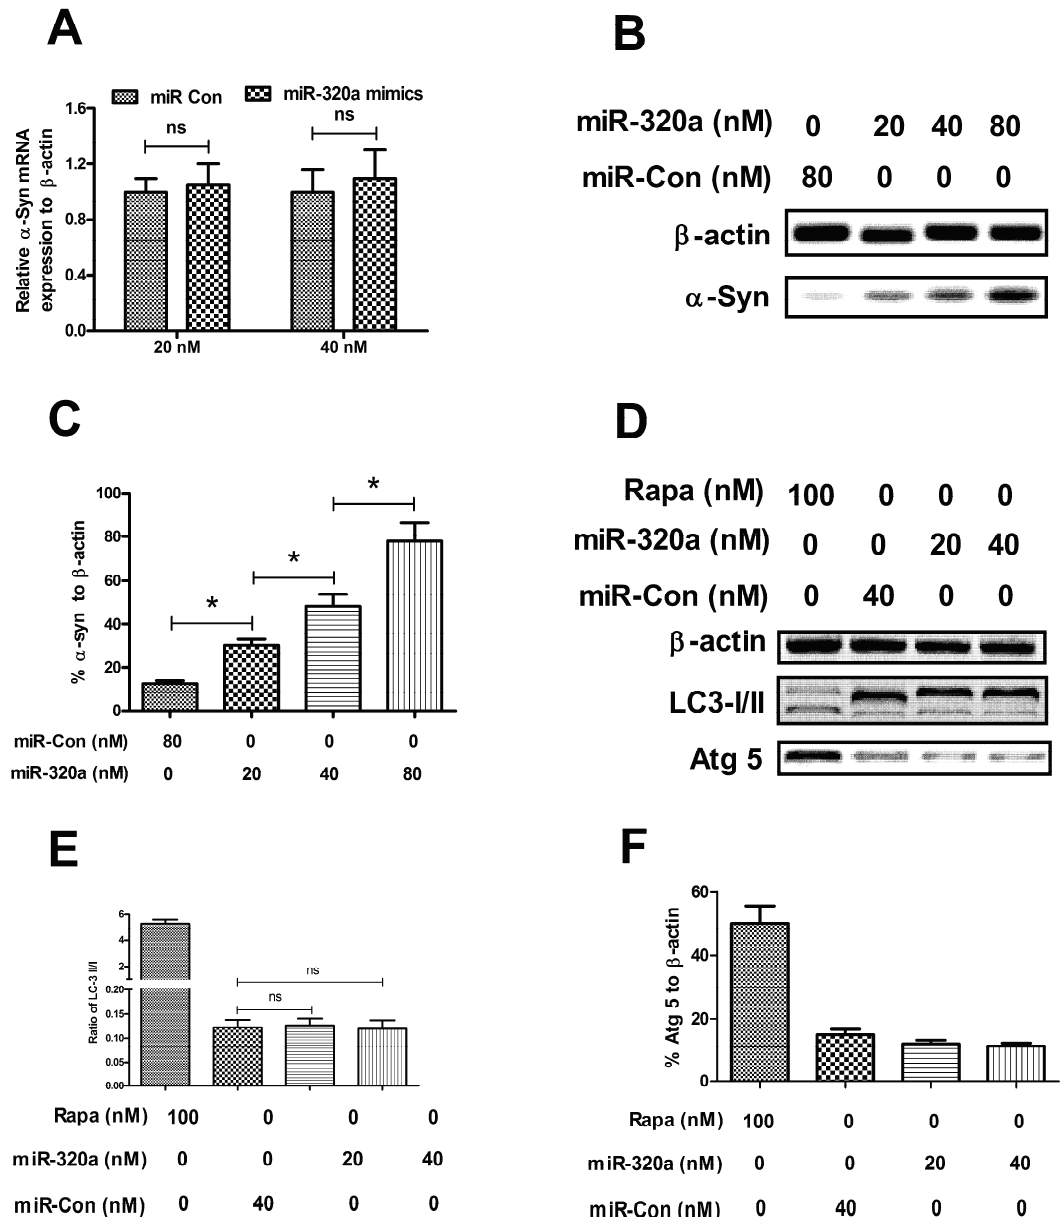
Figure 4. miRNA-320a inhibited α -synuclein degradation in SH-SY5Y-Syn(+) cells. ( A ) α -Syn expression in mRNA level in SH-SY5Y-Syn(+) cells post miR-320a mimics or miRNA control transfection; ( B ) Western blot analysis of α -Syn in SH-SY5Y-Syn(+) cells post miR-320a mimics or miRNA control transfection; ( C ) Significant increase in α -Syn aggragation in SH-SY5Y-Syn(+) cells by miR-320a mimics transfection; ( D ) Western blot analysis of autophagy-associated molecules, LC-3 I/II and Atg 5 in SH-SY5Y-Syn(+) cells post miR-320a mimics or miRNA control transfection; ( E ) miR-320a mimics transfection had no influence on the conversion of LC3-II to LC3-I; and ( F ) miR-320a mimics transfection had no influence on the Atg 5 expression in protein level. The experiments were performed separately in triplicate. Statistical significance was shown as * p < 0.05, ns, no